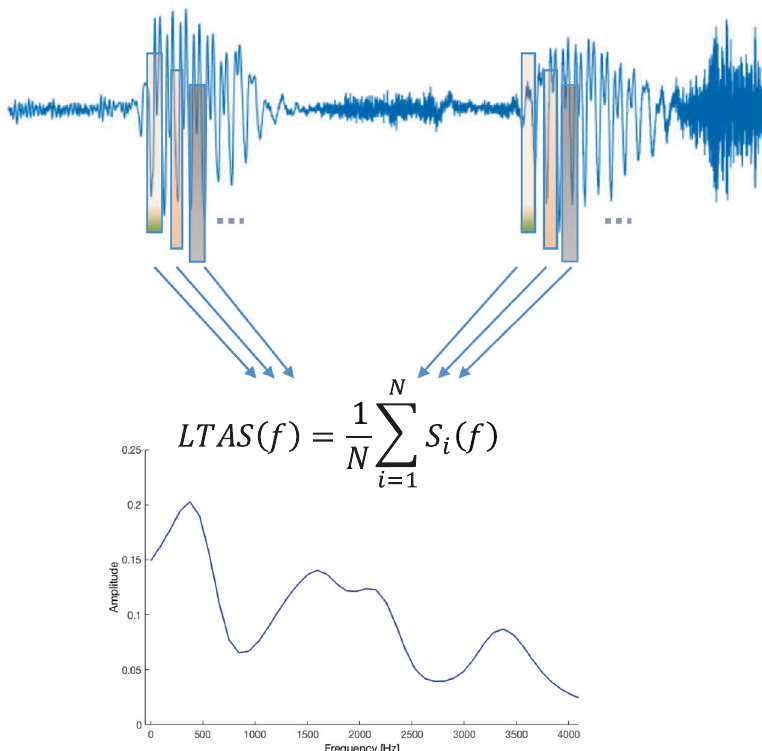
Fig. 2 Long-term average spectrum (LTAS) estimation strategy and example. Upper. Long-term average spectrum estimation strategy. Lower. An example of LTAS. The features, provided in Table 2, were identi fi ed to parsimoniously describe the LTAS